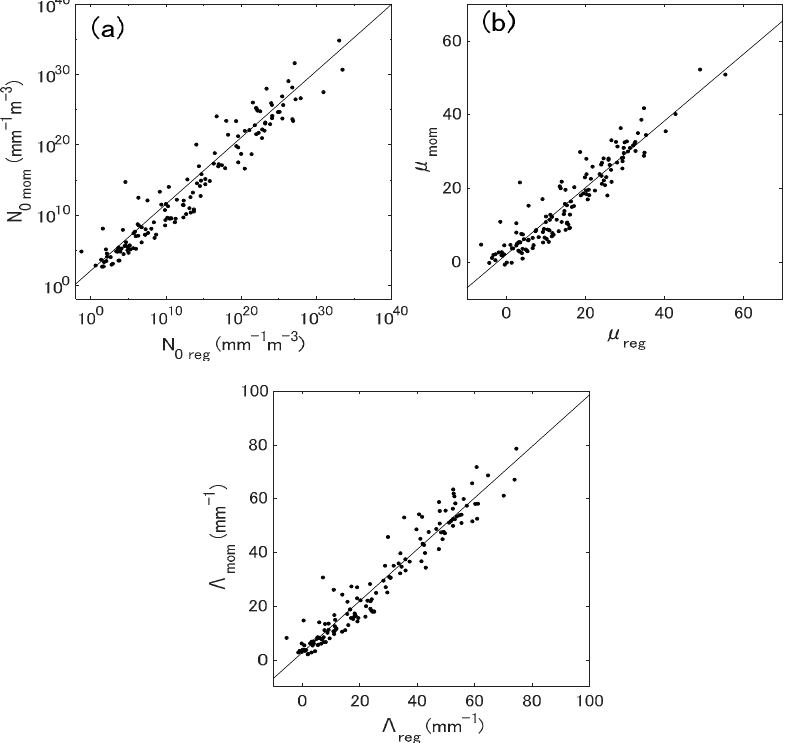
Figure 15. Comparison of gamma PSD parameters obtained from the complete momentum method and non-linear regression analysis. ( a ) log N 0 , ( b ) μ , and ( c ) Λ .